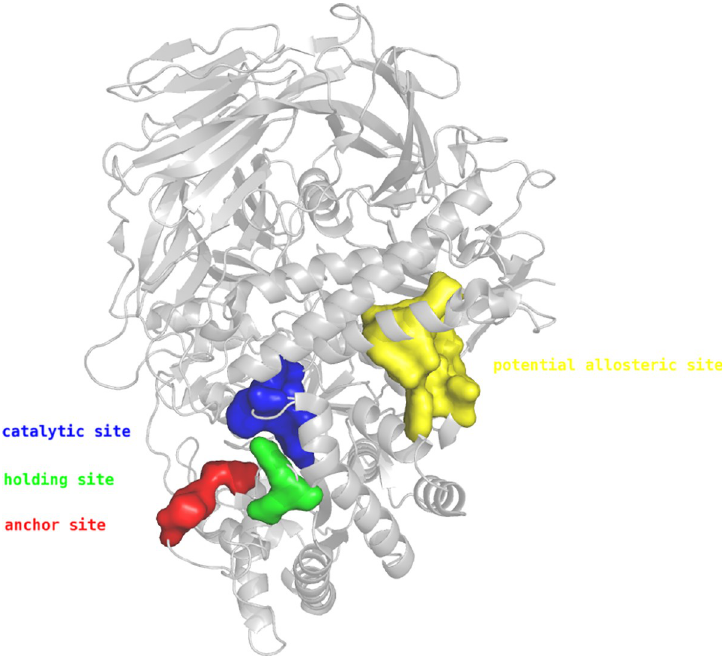
Fig 1. Overview of the different locations of the active site consisting of the catalytic site (blue), holding site (green), anchor site (red) with the potential allosteric site (yellow) within dGMII [3].